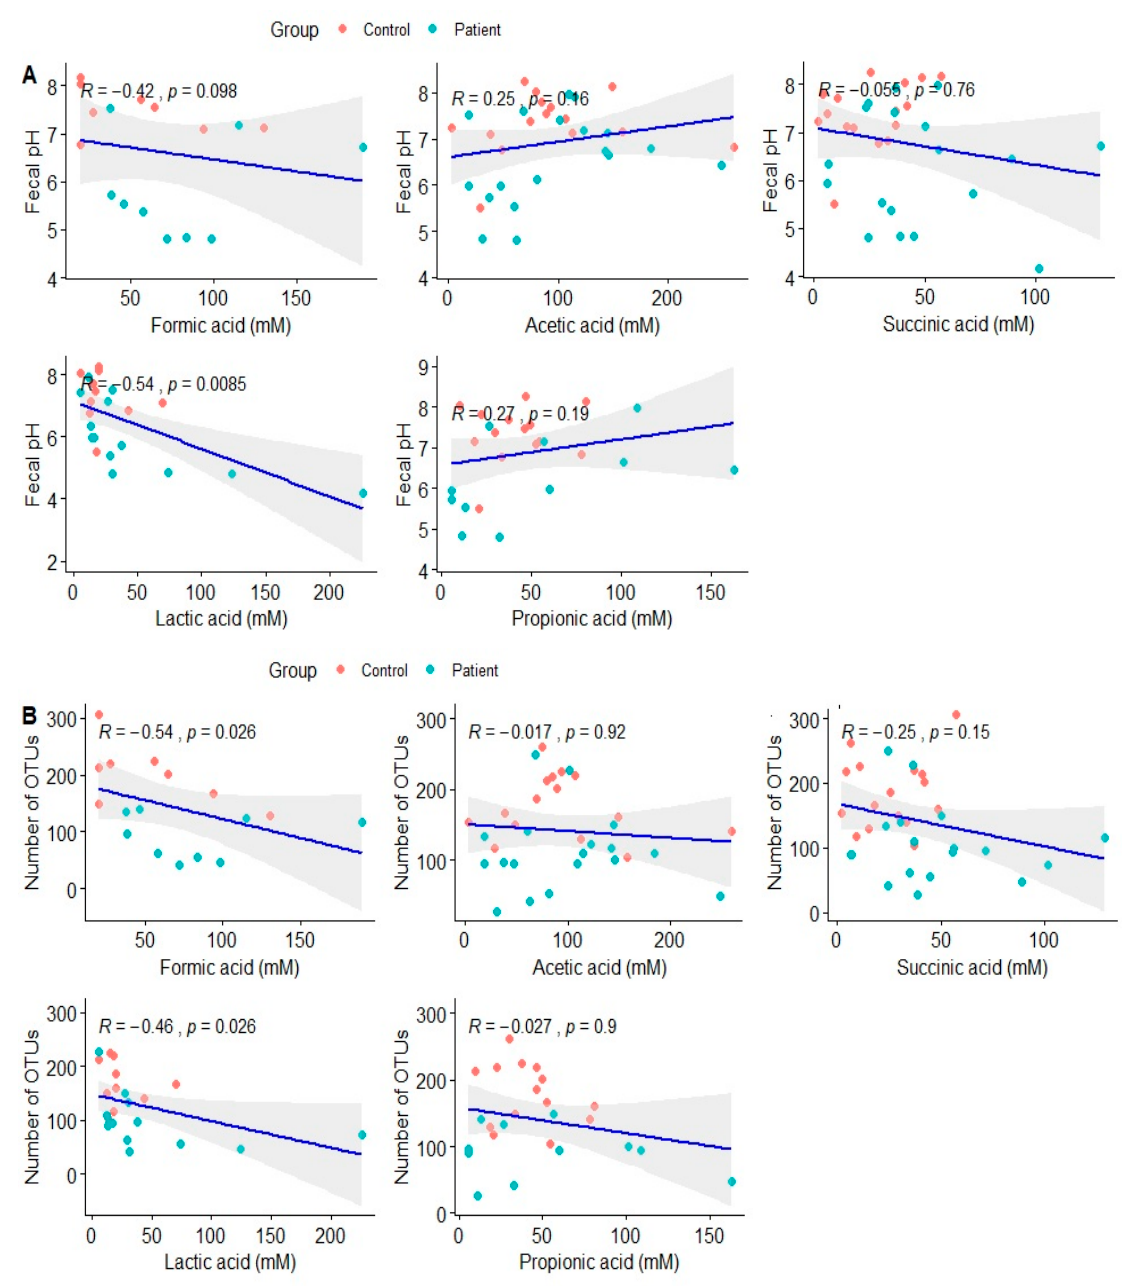
Figure 2. Panel show correlations of acetic, propionic, succinic, lactic and formic acids with ( A ) fecal pH; and ( B ) Observed OTUs between OTUs in fecal samples of patients and controls. No variation was found among the metabolites when GSD Ia and GSD Ib patients were compared. The number of valid observations did not allow a comparison with GSD type III and IX (Table 2). Metabolites were not directly related to the calprotectin levels found on patients (Figure 3). Additionally, the relationship between BMI and SCFAs was analyzed (data not shown), but no statistically significant difference was observed.